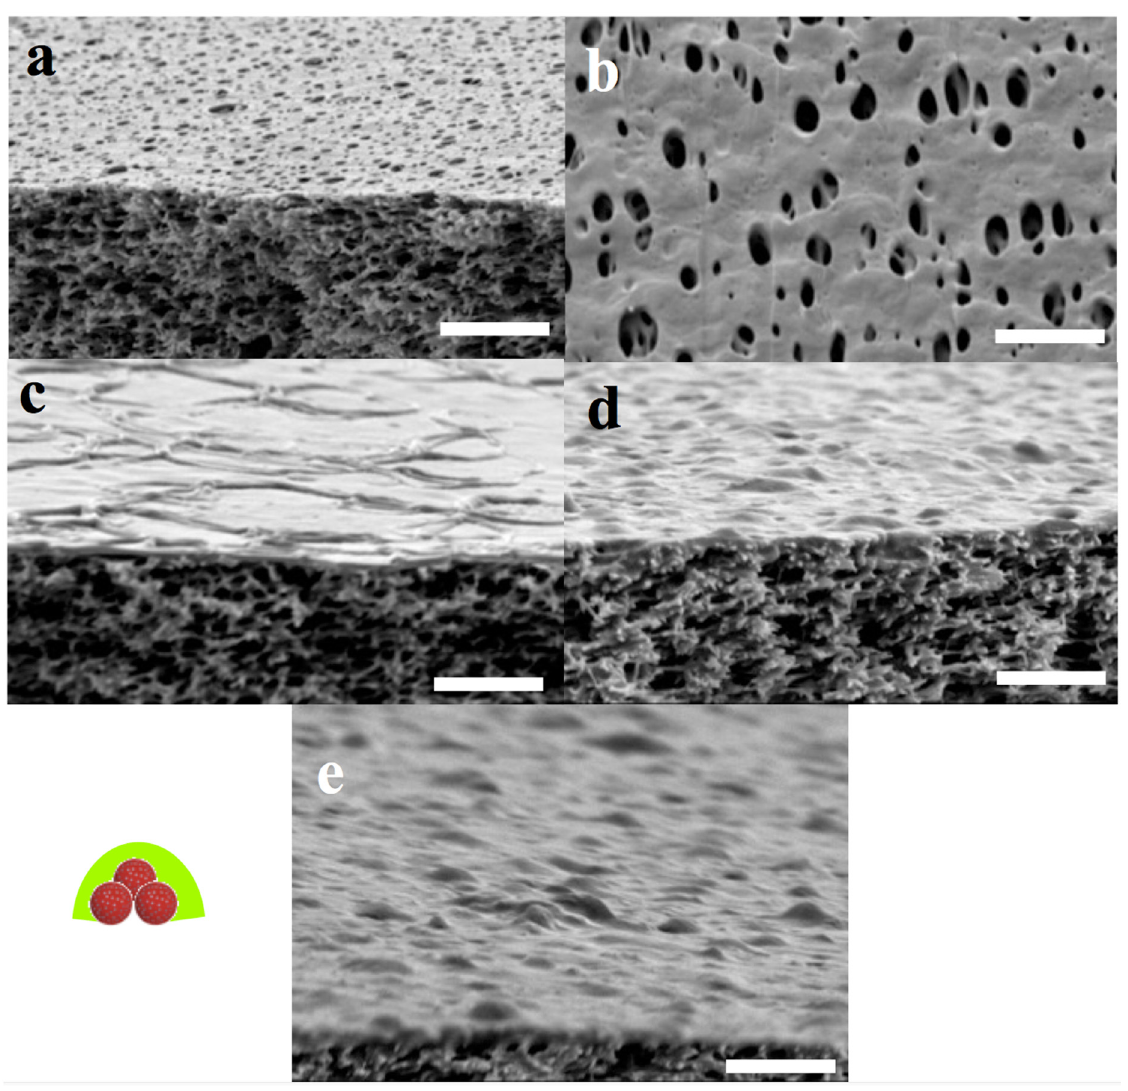
Figure 14. SEM images of MF PES ( a , b ) supported POSS+TMC AL on MF PES ( c ) and supported POSS/polymersomes+TMC on MF PES ( d , e ). Schematic sketch of polymersome coverage left to ( e ). Micropores of the MF PES were covered completely by the